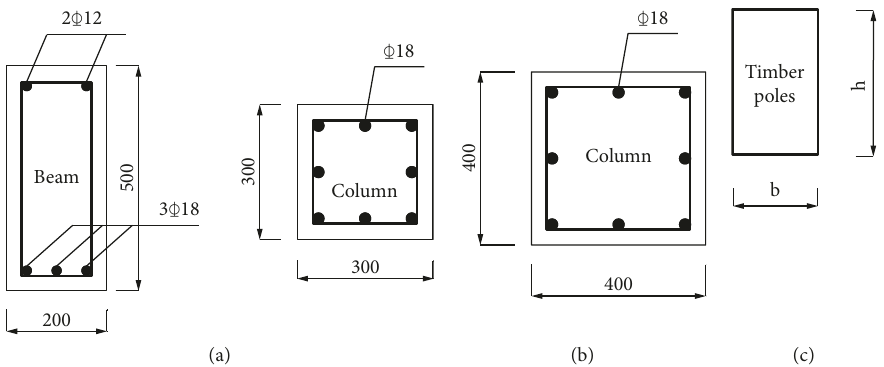
Figure 2: (a) Reinforcement configurations of beams and columns of PDS; (b) reinforcement configurations of columns of SDS; (c) parameters of timber pole cross